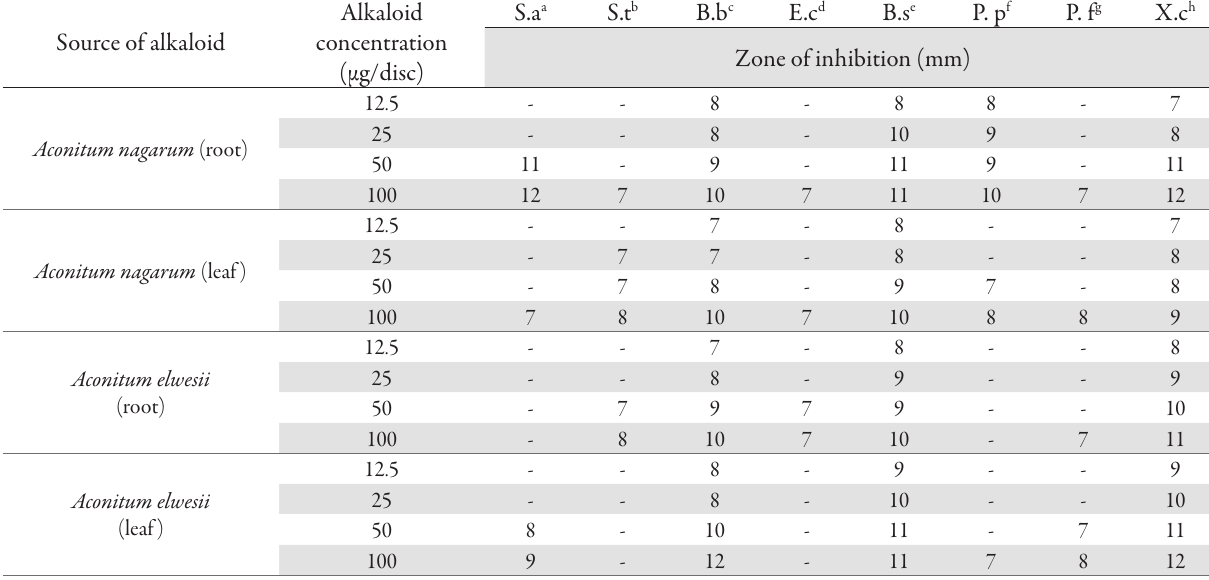
Tab. 2. Antibacterial activity of alkaloid extract from Aconitum spp. Source of alkaloid